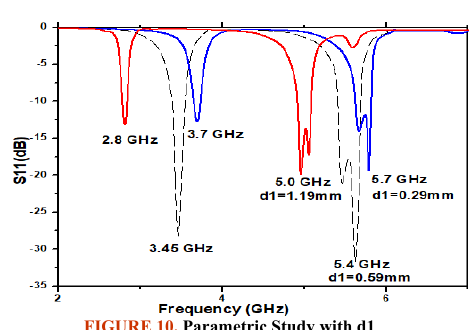
FIGURE 10. Parametric Study with d1